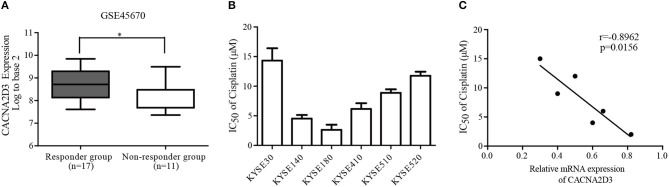
Downregulation of CACNA2D3 is associated with poor chemotherapy response in ESCC. (A) Box and whisker plot of CACNA2D3 mRNA levels in neoadjuvant chemotherapy responder and non-responder groups (GSE45670). *p < 0.05. (B) IC50 values for cisplatin in six ESCC cell lines. Cells were treated with a range of concentrations of cisplatin for 72 h, and IC50 was calculated. Data are represented as the mean ± SD of three independent experiments. (C) Correlation of CACNA2D3 mRNA levels and IC50 values for cisplatin in six ESCC cell lines. r, Pearson correlation coefficient.